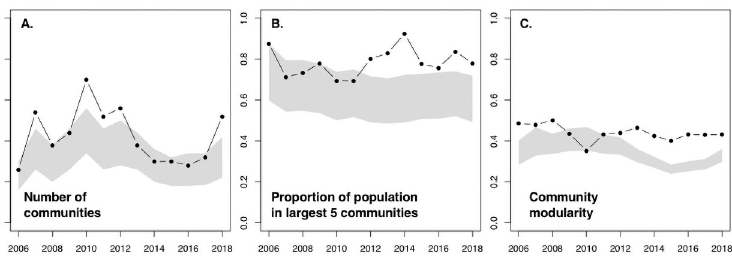
Fig 6. Annual time series of association network structure metrics, based on a four-year running window (2004– 2007, 2005–2008, ... , 2016–2019; n = 12) for the population of humpback whales seen on at least five occasions throughout the 16-year study. The observed structure metrics (black line and dots) are compared to a null model based upon 1,000 randomizations each of the original sighting records within each four-year interval (grey shaded area is 95% confidence interval of these randomizations, based on 0.025 and 0.975 quantiles). Significantly non-random structural patterns are indicated by the departure of the black line from the grey shaded area. A . The number of communities within the network, as identified by the Louvain algorithm in igraph. B . The proportion of the population contained within the five largest communities identified by the clustering algorithm. C . The modularity of the community structure.